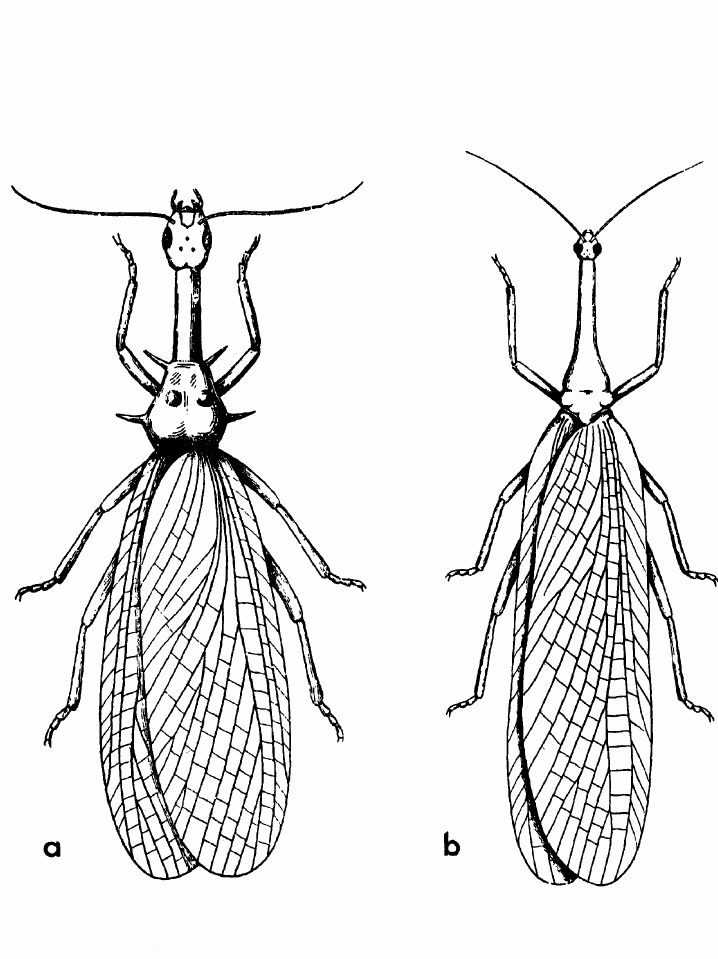
Fig. 3. Handlirsch’s reconstructions of two species of Gerarus. a. G. danielsi; b. G. collaris (=lontcicollis). (From Handlirsch,